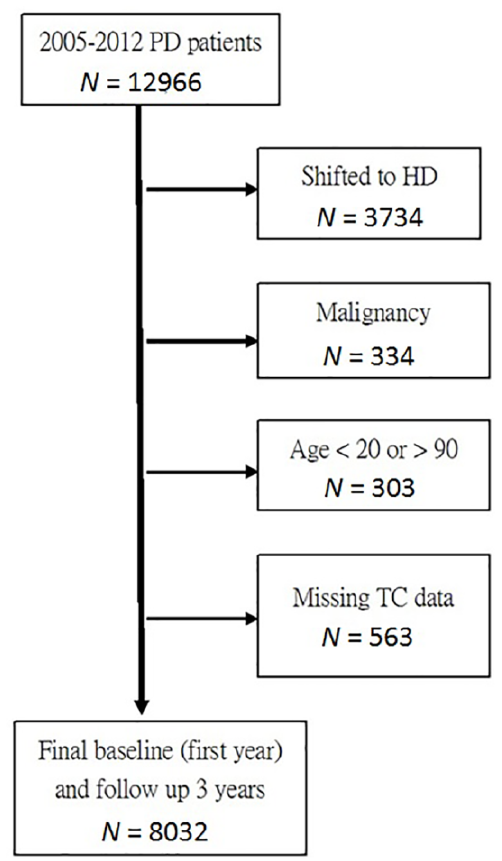
Figure 1. The flow chart of the study population ( n = 8032). PD: peritoneal dialysis; HD: hemodialysis; TC: total cholesterol.